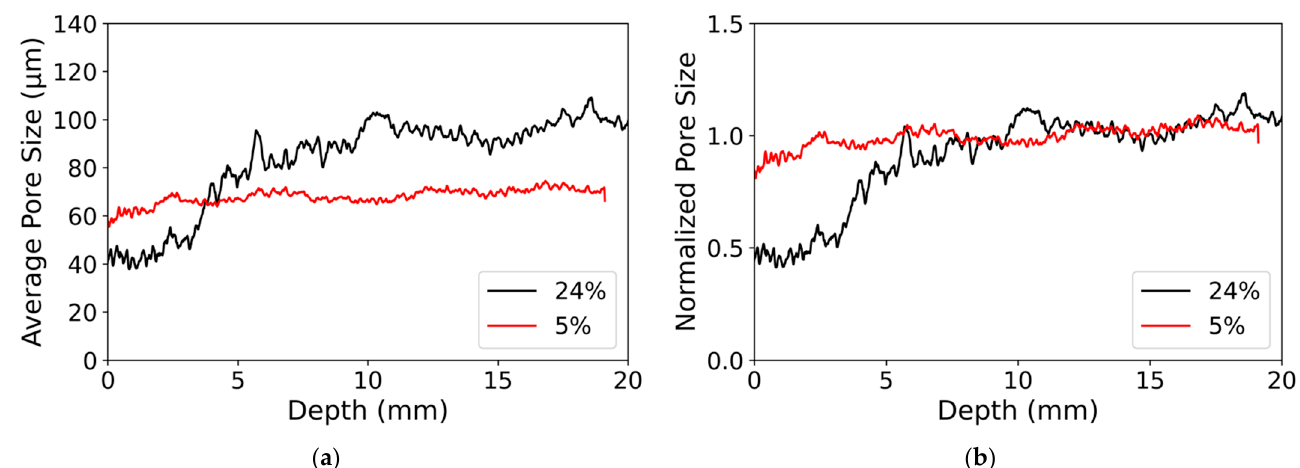
Figure 5. ( a ) Average pore size, in a slice perpendicular to the main axis of the cylindrical sample, as a function of depth from the top surface; ( b ) average pore size normalized as a function of depth from the top surface. Black lines: initial particle volume fraction 𝜑 = 24% ; red lines: initial particle volume fraction 𝜑 = 5% .